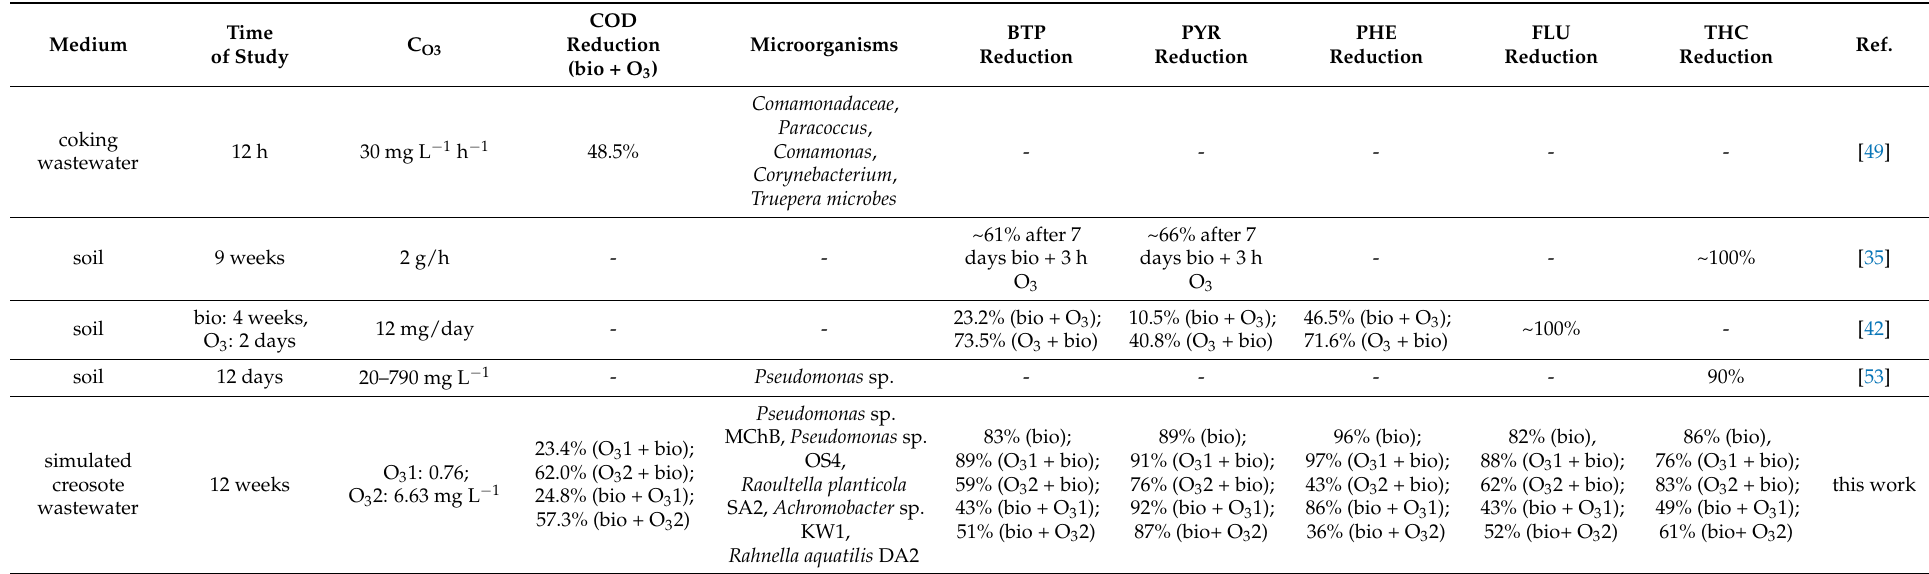
Table 2. Comparison of COD reduction and PAHs removal during biodegradation and